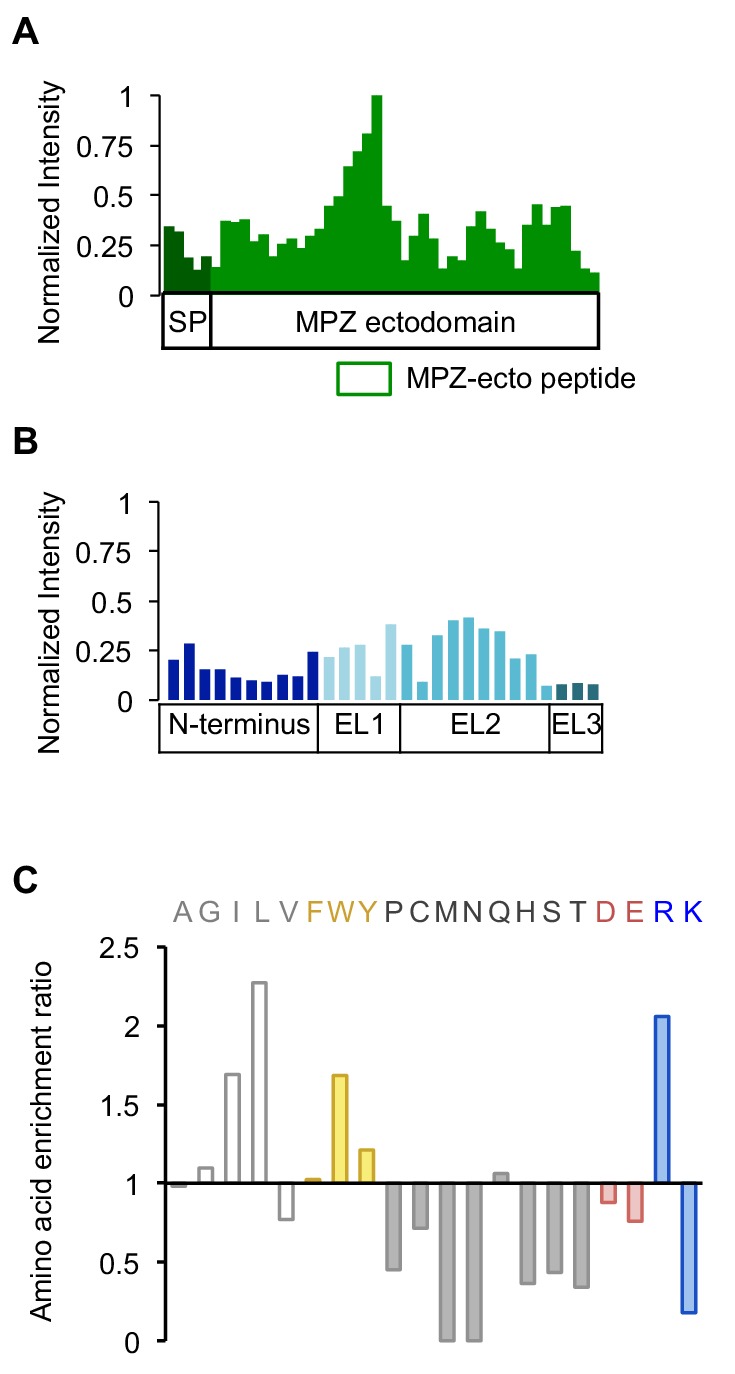
DR5 ECD binds to selective subset of sequences displayed by the secretory proteome.(A) Intensity values of each peptide spot in the MPZ section of the peptide array in Figure 3A were normalized to the spot of highest intensity within MPZ. Green box below denotes the peptide chosen as a candidate binder, called MPZ-ecto, shown in spots C18-C19 on the array. Sequences for the peptides are listed in Figure 3—source data 1. (B) Intensity values of the RHO peptide array section in Figure 3A normalized to the highest intensity from MPZ. Peptides were derived from the extracellular N-terminus tail and the extracellular loops (EL1-EL3) that connect the transmembrane domains of rhodopsin. (C) Quantification of enriched amino acids from peptides with an intensity value greater than one standard deviation above the average signal, noted as a preferred peptide, within the entire array. Enrichment ratio for each amino acid was calculated as the frequency of occurrence in preferred peptides divided by its total frequency on the array.